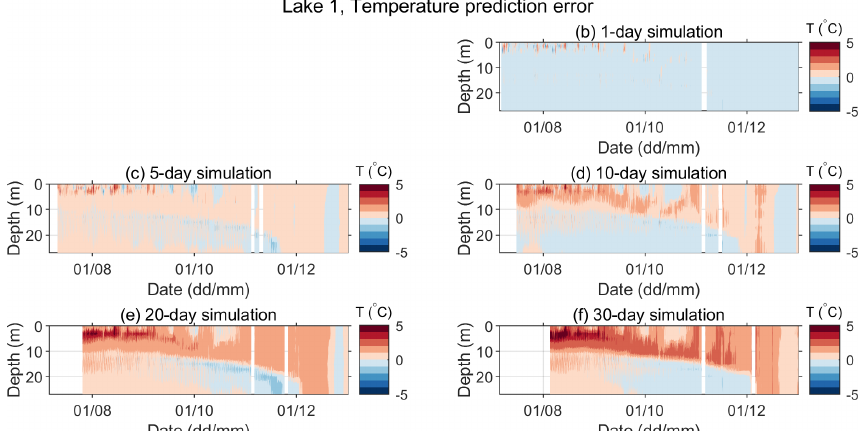
Figure A1. Error in the predicted water temperature ( P i − O i ) for Lake 1 for different simulation lengths for the period between 6 July and 31 December 2019. Panel (a) is omitted so that the panels’ positions for different simulation lengths correspond to those in Fig. 6.